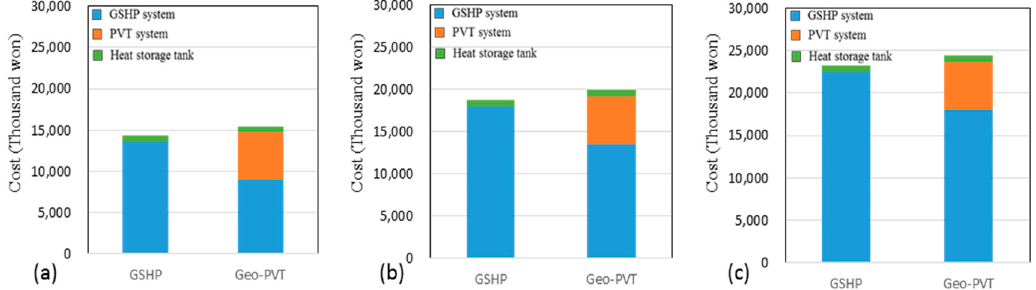
Figure 37. Heat production of PVT system considering change method of using solar heat. ( a ) 99 m 2 building area; ( b ) 165 m 2 building area; ( c ) 231 m 2 building area.